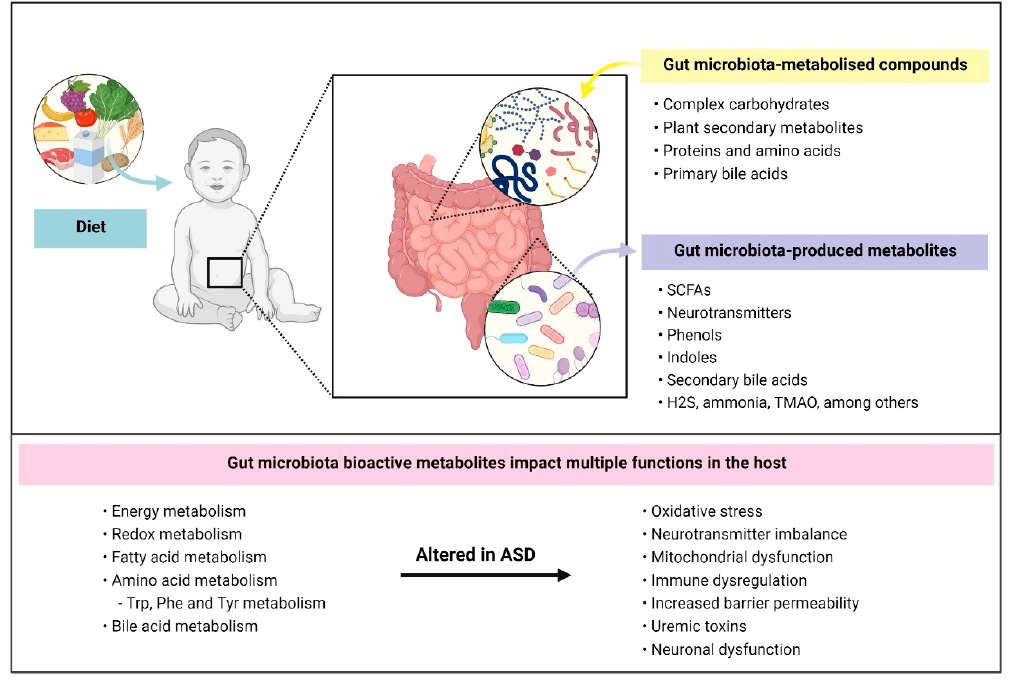
Figure 1. Gut-bacterial dependent metabolic pathways and their influence in ASD. Diet is a major contributing factor that influences gut microbiota composition and function. Intestinal bacteria mainly metabolise compounds that are unabsorbed by our gastrointestinal tract including (i) complex carbohydrates, (ii) plant secondary metabolites, (iii) proteins and amino acids, that come from digestive secretions, protein turnover and/or escape host digestion, and (iv) primary bile acids. Bacterial metabolisation of these compounds results in the production of bioactive metabolites such as short-chain fatty acids, neurotransmitters, indolic and phenolic compounds. Several metabolic pathways were reported to be altered in ASD such as redox and aromatic acid metabolism. In turn, metabolic dysfunction mediated by gut microbiota may lead to other complications in individuals affected by ASD such as impaired neuronal function, oxidative stress and increased intestinal and blood–brain barrier permeability. SCFAs: short-chain fatty acids; H2S: hydrogen sulfide; TMAO: trimethylamine N-oxide; Trp: tryptophan; Phe: phenylalanine; Tyr: